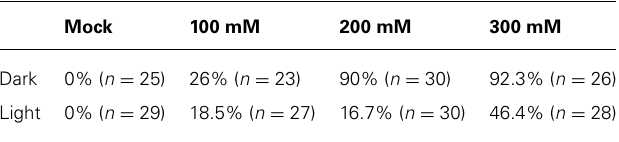
Table 1 | Halotropic bendings of Arabidopsis roots grown in different light conditions. Mock 100 mM 200 mM 300 mM Dark 0% ( n = 25) 26% ( n = 23) 90% ( n = 30) 92.3% ( n = 26)